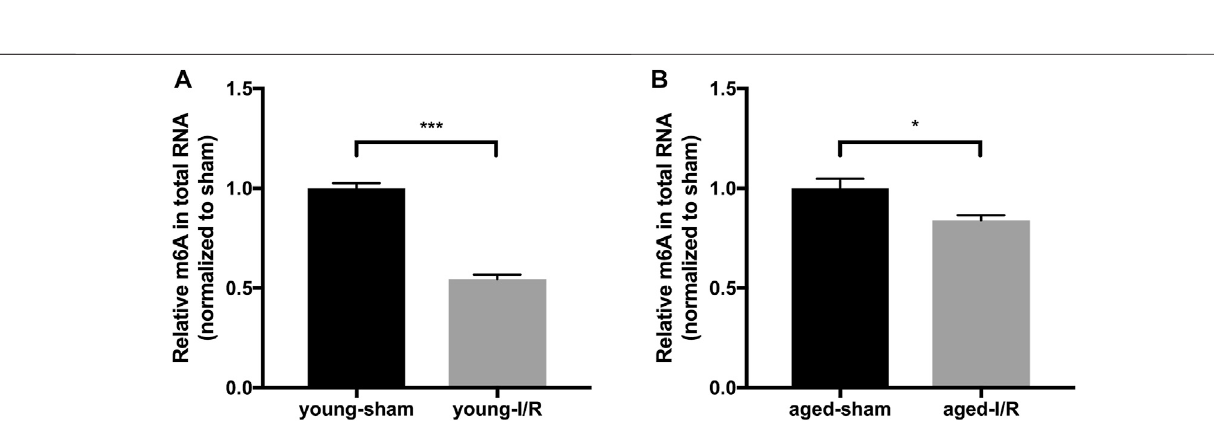
Frontiers in Pharmacology |